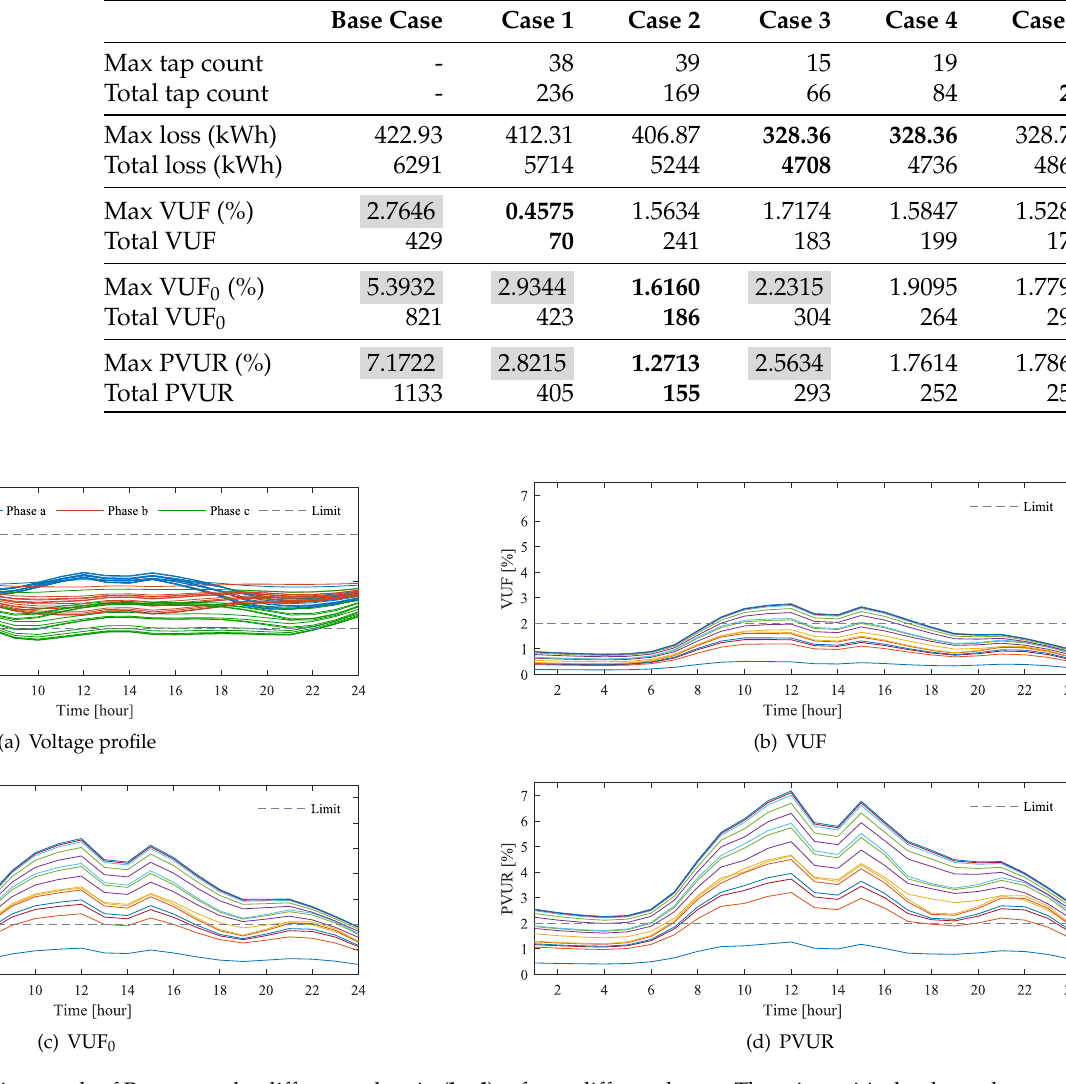
Figure 4. Simulation result of Base case; the different colors in ( b – d ) refer to different buses. There is a critical voltage drop in phase c , and each unbalance metric during the day is much higher than the limit.